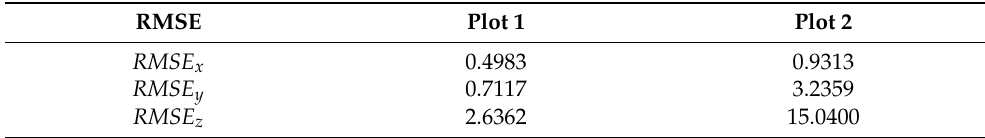
Table 3. Root mean square error without the use of